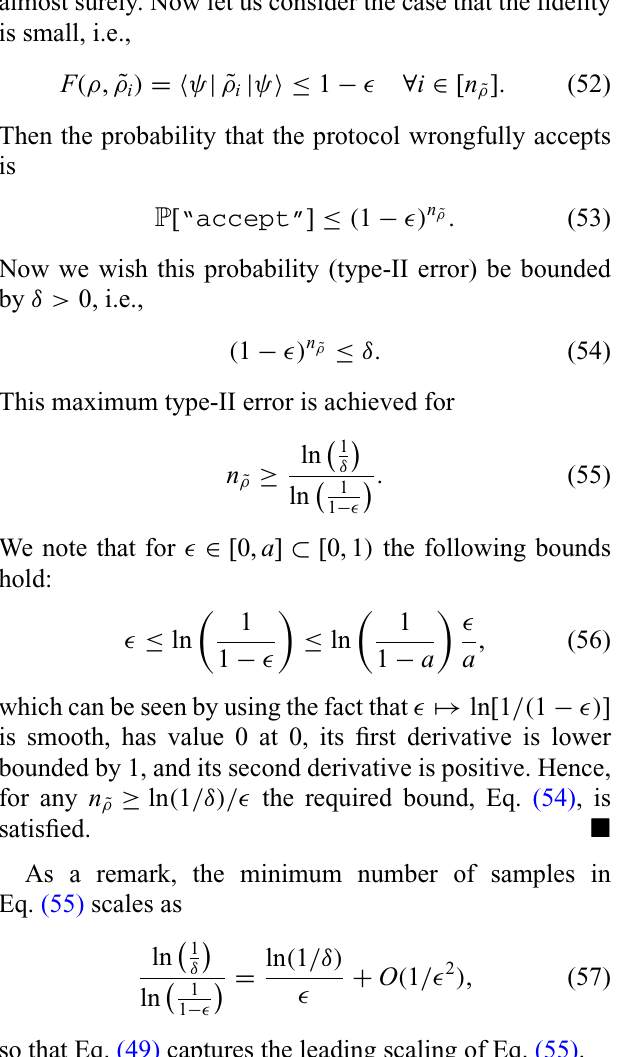
Protocol 17 (Direct state certification): Let ρ ∈ S ( C d ) be a pure target state and ( M , μ) be a probabilistic